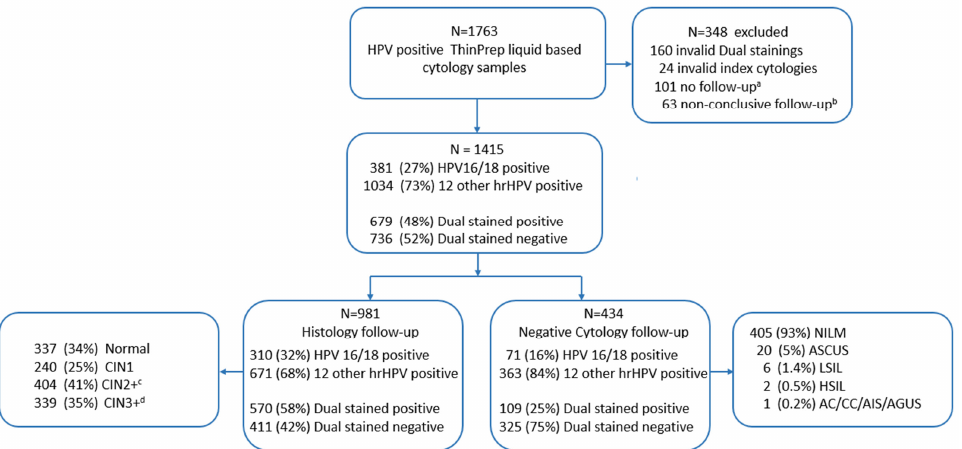
Figure 1. Flow Scheme of the study cohort showing partial HPV genotyping and dual staining results of the index cytology of samples included in the study. a missing follow-up after index cytology; b follow-up with HPV positive cytology, regardless of cytology diagnosis. c CIN2, CIN3, AIS/CIS and CC; d CIN3, AIS/CIS and CC.